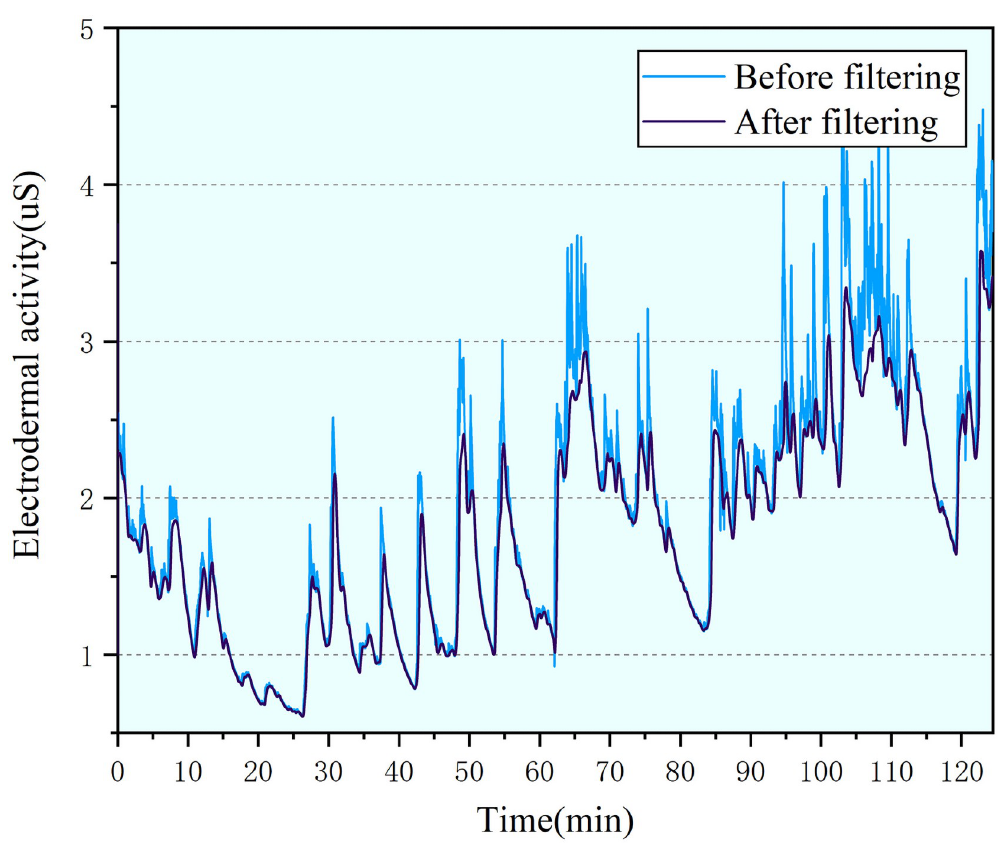
Fig 13. Comparison of EDA signal before and after